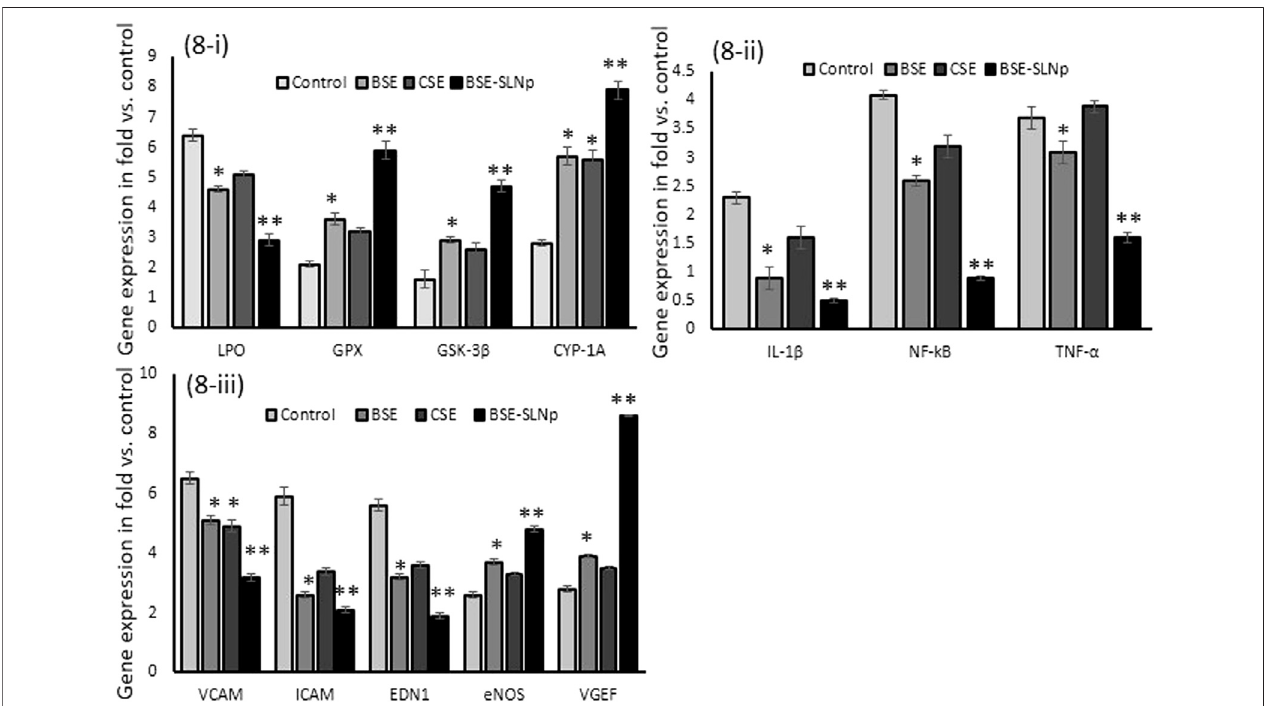
FIGURE 8 | Effect of BSE, CSE, and BSE-SLNp on oxidative stress and antioxidant (8i) , proin fl ammatory (8ii) , and vascular cell in fl ammation (8iii) related gene expression levels inH